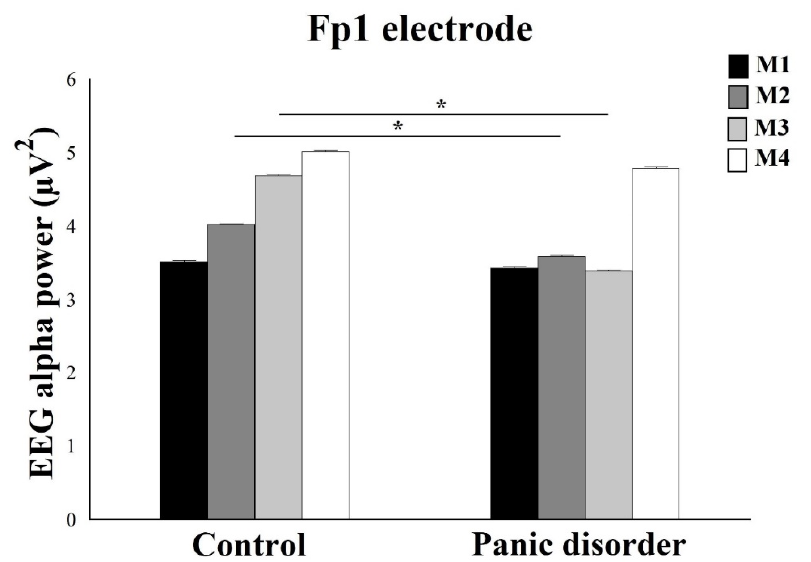
Figure 4. In relation to the Fp1 electrode, the analysis shows a decrease in the EEG alpha power in the experimental group when compared to control for moment M2 and M3. The interaction between group and moment for the left frontopolar cortex is demonstrated by mean ± standard error, and statistically significant difference is indicated with *, p ≤ 0.0125.